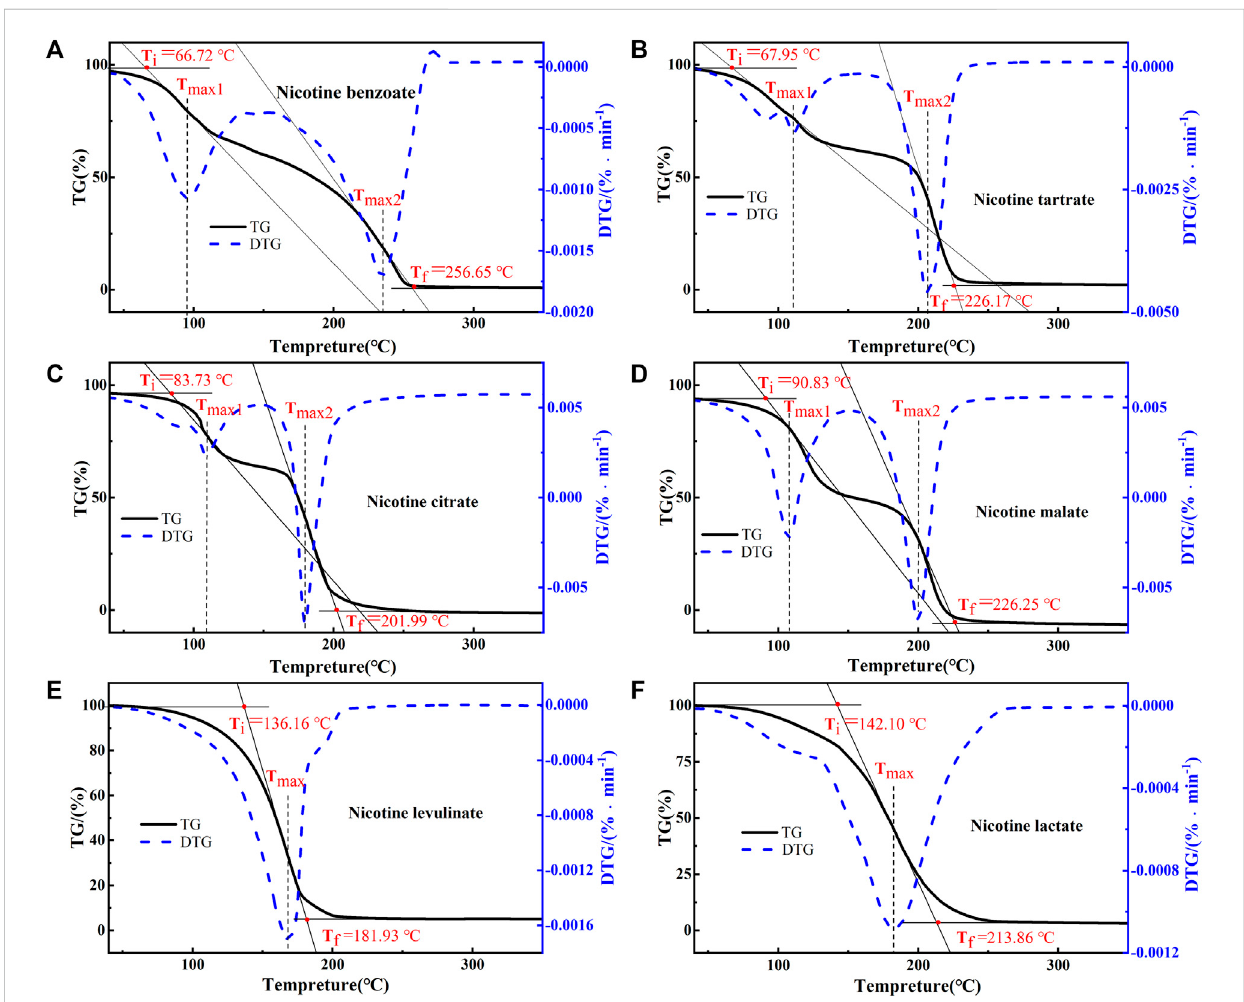
FIGURE 2 TG – DTG curves of six nicotine salts: (A) nicotine benzoate, (B) nicotine tartrate, (C) nicotine citrate, (D) nicotine malate, (E) nicotine levulinate, and (F) nicotine lactate.